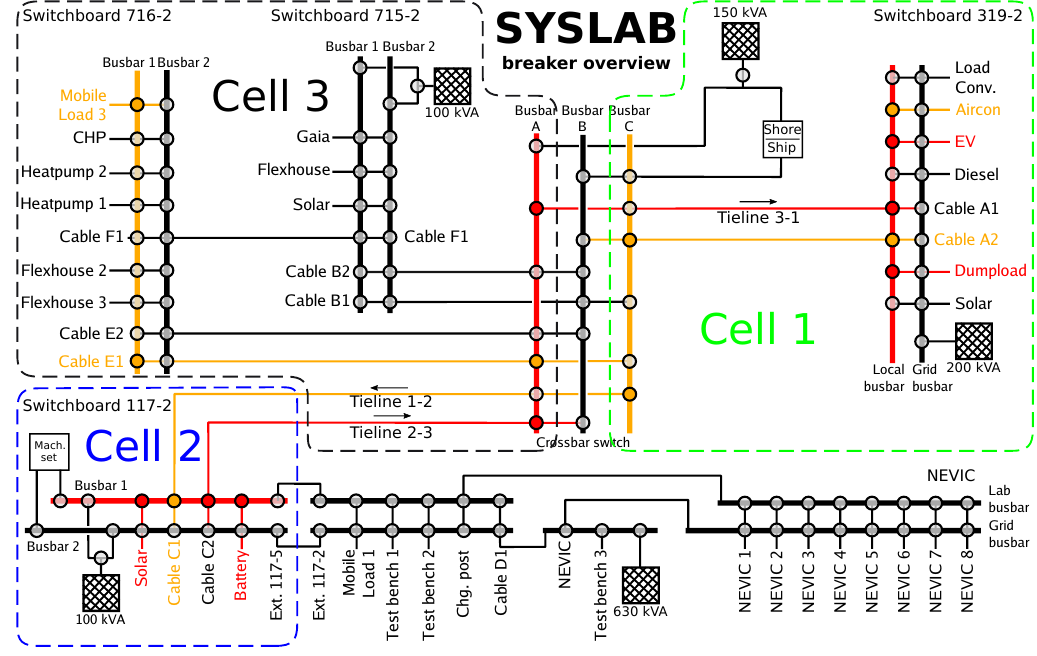
Figure 3. SYSLAB layouts for the two test cases. Devices and lines used in the one-cell case are marked in red. Additional components for the three-cell case are indicated in orange.